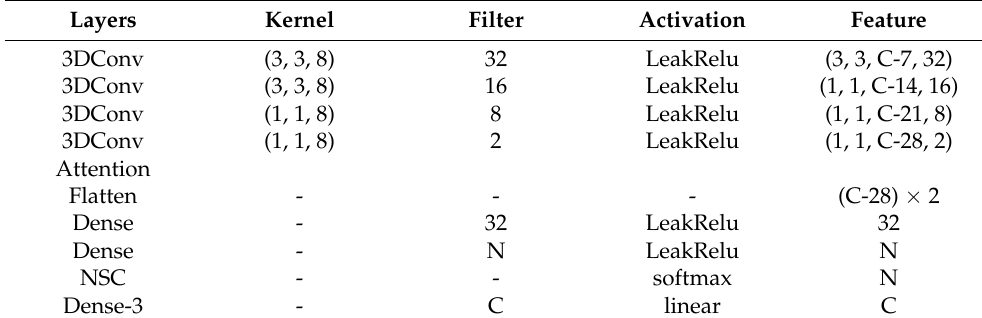
Figure 1. Diagram of the proposed 3D convolutional neural network. Table 1. The structure of the CACAE model.